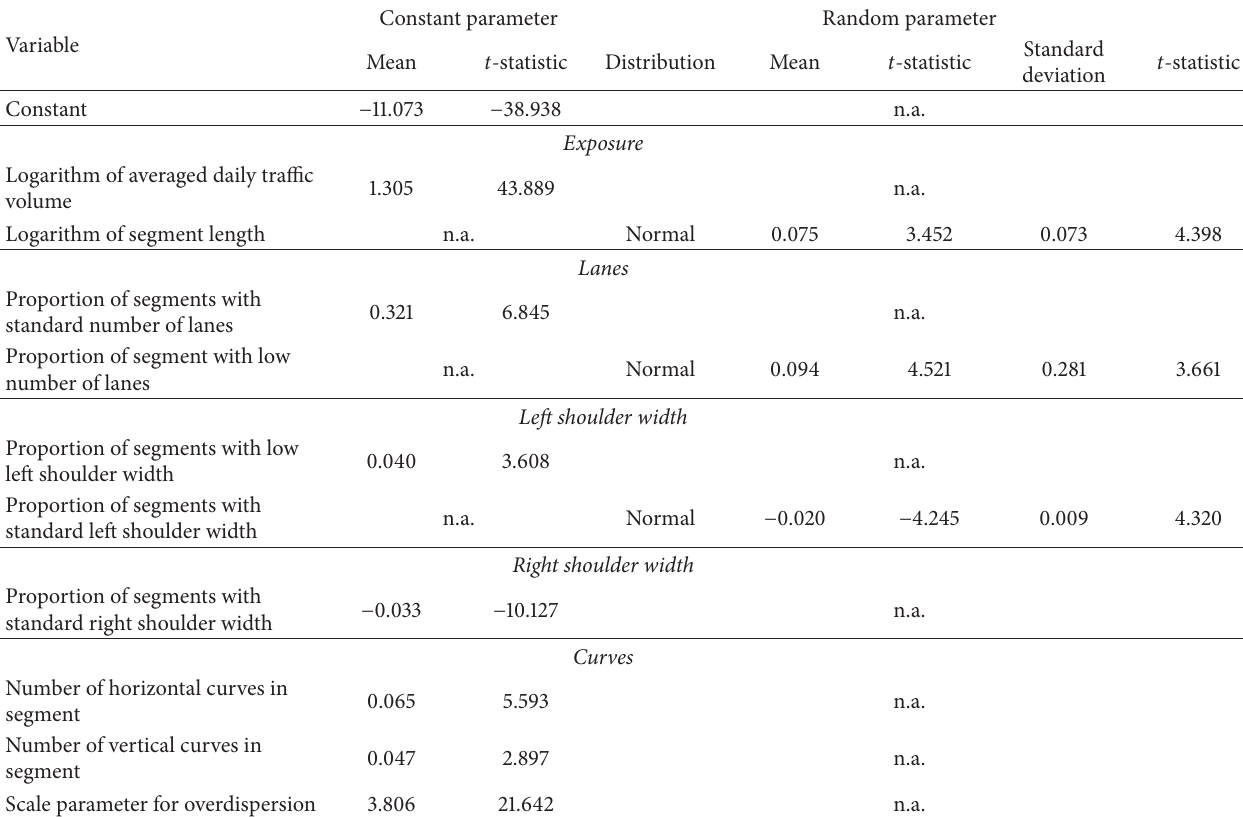
Table 3: Model results for segments with lighting